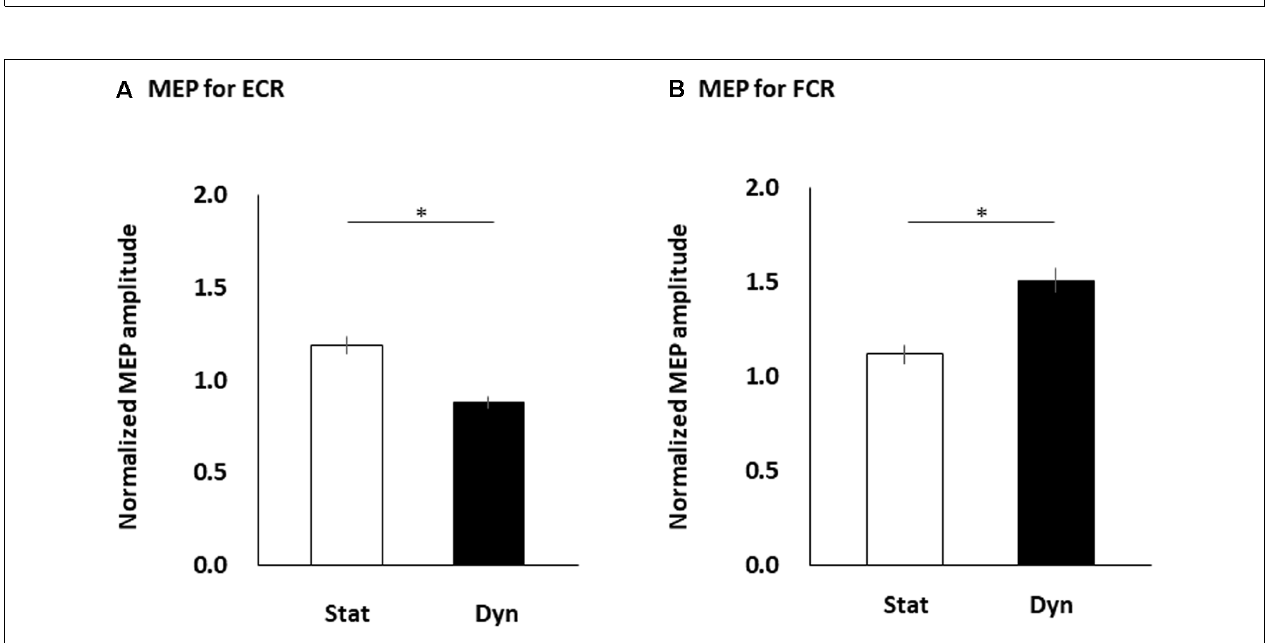
FIGURE 3 | The MEP amplitudes of the ECR (A) and FCR (B) muscles during the resting and control conditions. The columns and error bars denote the means and standard errors of the mean, respectively. The ECR MEP amplitudes significantly increased in the control condition compared to the resting condition ( ∗ p < 0.0001). However, there was no significant change in the FCR MEP amplitudes between the control and resting conditions ( p = 0.176). MEP, motor evoked potential; FCR, flexor carpi radialis; ECR, extensor carpi radialis; Res, resting condition; cont, control condition.